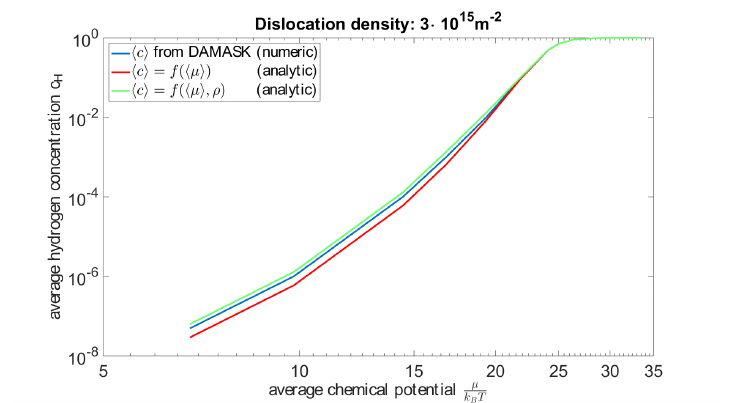
Figure 5. Comparison of the numerical solution (blue) with the old analytical solution (red), which includes no dislocation density and the new analytical solution (green) for different dislocation densities. Including the dislocation density substantially improves the accuracy of the analytically approximation.